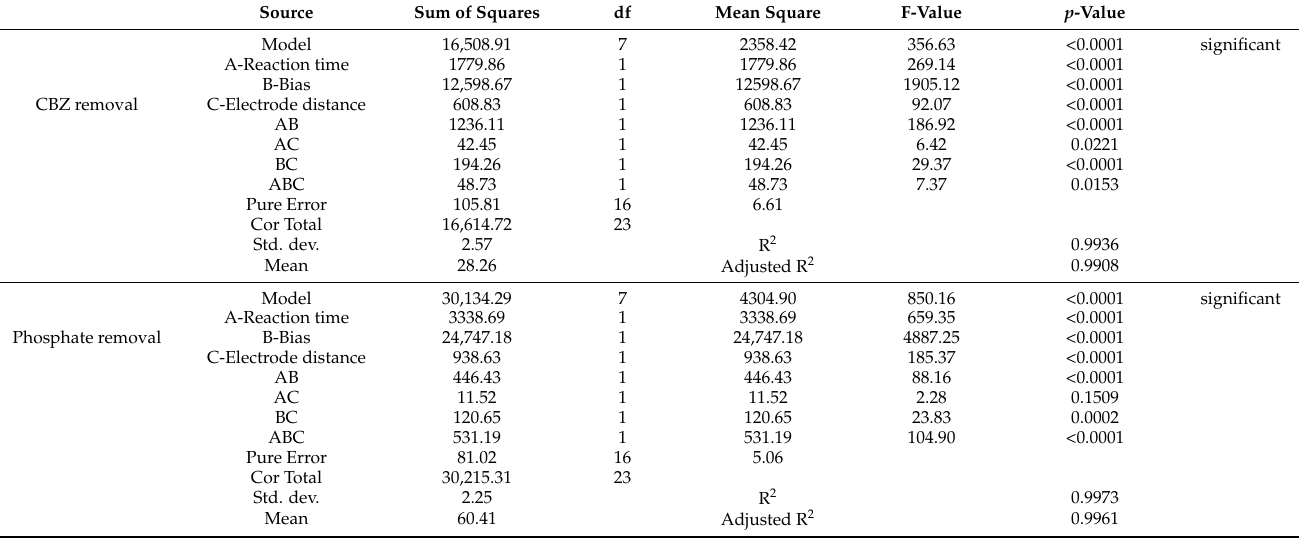
Table 4. ANOVA results for CBZ and phosphate removal